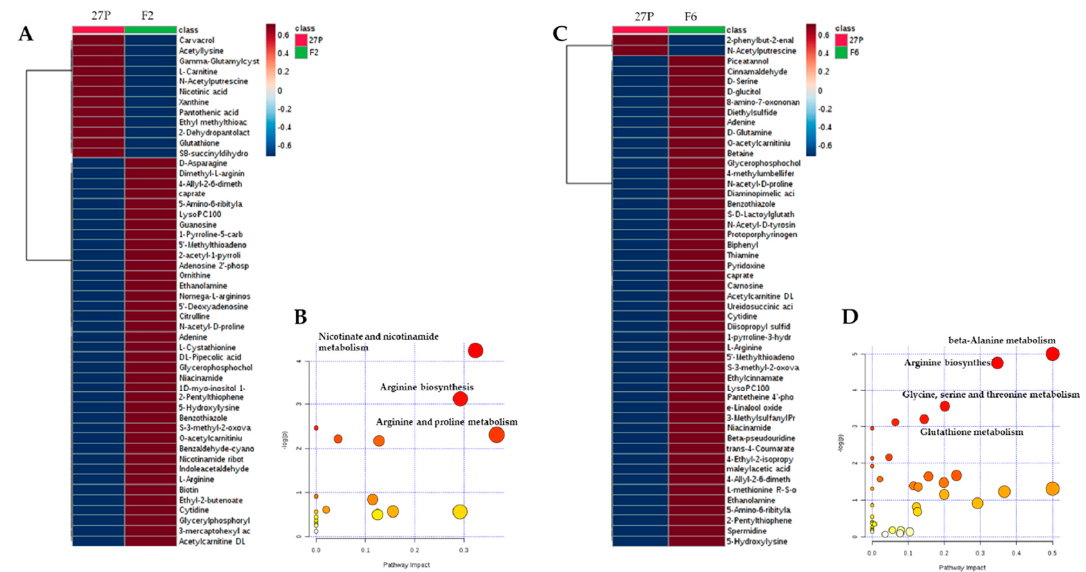
Figure 4. Heatmap of the top 50 metabolites significantly changed after exposure to increasing concentrations of ethanol (20–24% v / v) between the cells of 27P compared to those of F2 ( A ) or F6 ( C ). The analysis of the most important metabolomic pathways di ff erentially perturbed by ethanol stress is also reported for F2 ( B ) and F6 ( D ) cells. Legend. y-axis: -log(p) represents metabolic pathways containing metabolites that are significantly di ff erent between parental and the recombinant strain. x-axis: pathway impact represents the impact of these significantly changed metabolites on the overall pathway, based on their position / number within the